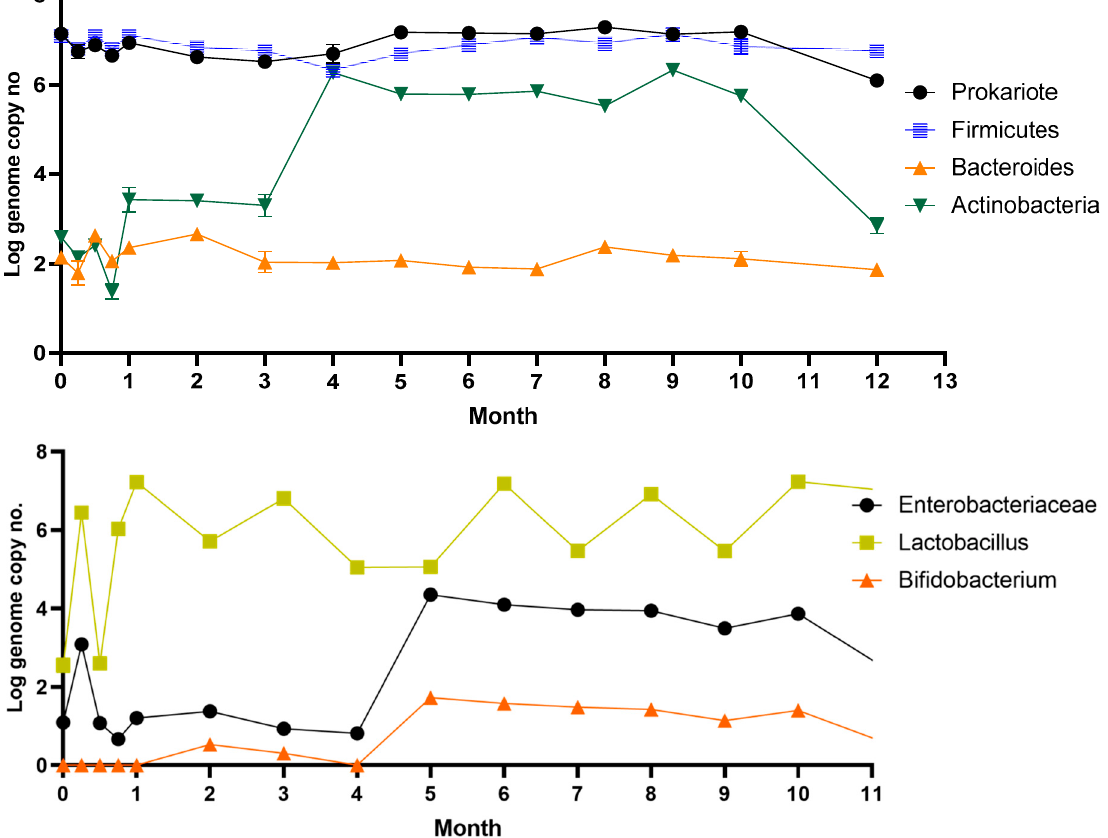
Figure 1. Long-term stevia effect on the main groups of bacteria after in vitro long-term stevioside Figure 1. Long ‐ term stevia effect on the main groups of bacteria after in vitro long ‐ term stevioside consumption.